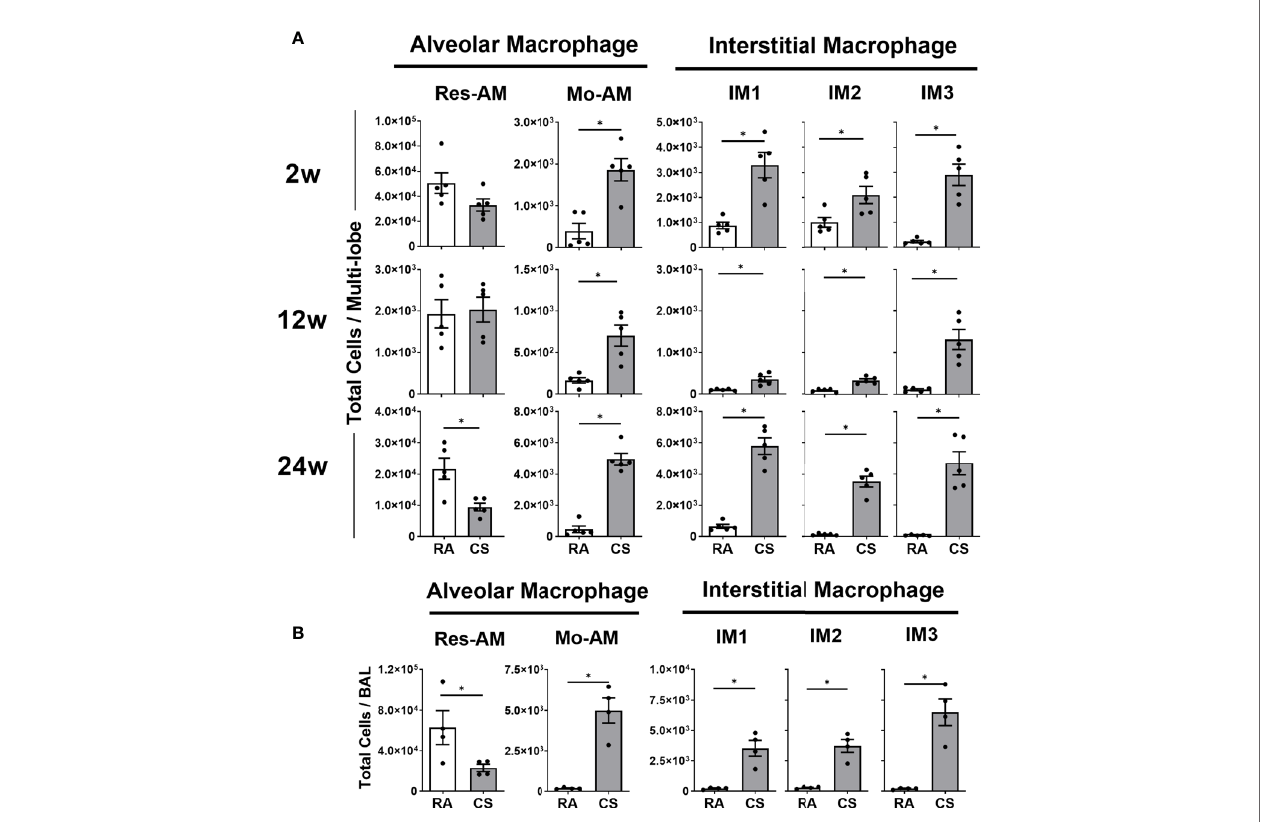
FIGURE 1 | Cigarette smoke exposure alters pulmonary macrophage subpopulation composition expanding CD11b + populations. Female C57BL/6 mice were RA or CS-exposed for 2- to 24-weeks. Data show total numbers of Res-AM, Mo-AM, IM1, IM2, and IM3 populations in (A) lung tissue and (B) bronchoalveolar lavage (BAL). Data show mean ± SEM, n = 5. Unpaired t test with Welch ’ s correction. RA, room air; CS, cigarette smoke. *p <